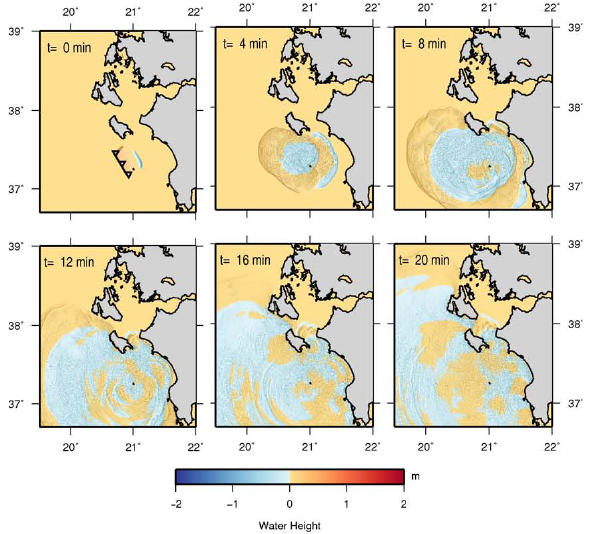
Fig. 8. Snapshots of the tsunami propagation from the source 3 (Cephalonia South fault) at 4-min